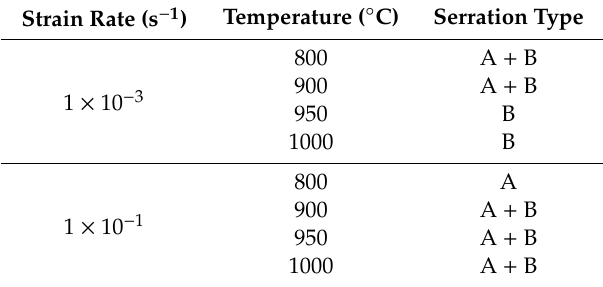
Figure 43. True stress–true strain plots at different temperatures and strain rates of ( a ) 10 −1 and ( b ) 10 −3 s −1 (reproduced from Reference [162] with permission).